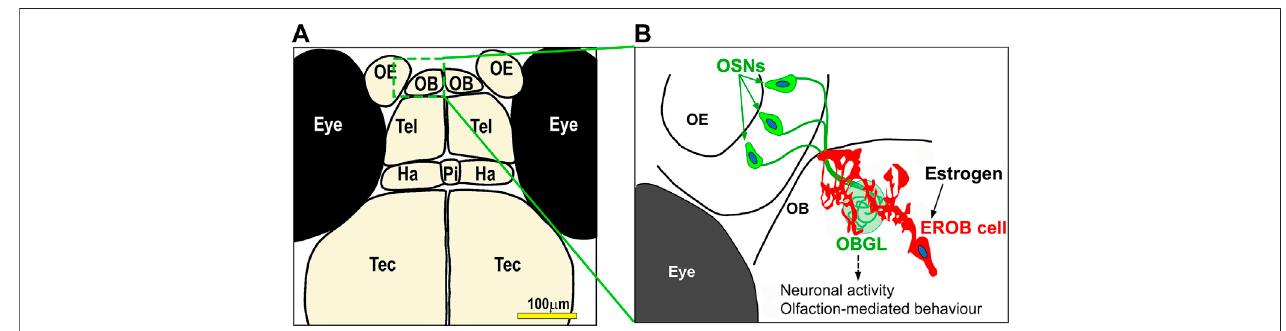
FIGURE 2 | A model for estrogen-mediated regulation of development of olfactory sensory system in zebra fi sh embryo. (A) Illustration of the forebrain regions of four dpf zebra fi sh embryo/larvae. Olfactory epithelia, OE; olfactory bulb, OB; Tel, telencephalon; Ha, habenula; Pi, pineal; Tec, tectum. (B) A cartoon for estrogen responsiveolfactorybulb(EROB)cellinfourdpfzebra fi shembryo/larvae.Fromtheearlyonsetofembryodevelopment(i.e.,27hpf),estrogenactsonaspeci fi cgliainthe OB (estrogen responsive olfactory bulb (EROB) cells), inducing estrogen/ER-mediated transcription. The EROB cell in turn regulates olfactory glomerular development through tight interaction with projections of olfactory sensory neurons (OSNs) at the OB glomeruli (OBGL). We have shown that this exposure to estrogen during early life affects the EROB cells altering the local excitability of the OB, eventually leading to a defective olfaction-sensing capability in later life (Takesono et al.,